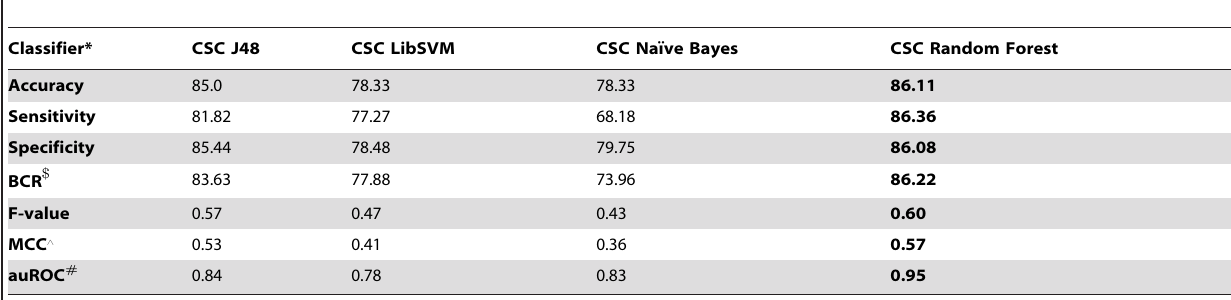
Table 5. Summary of statistical measures of the best classifiers on re-evaluation with independent